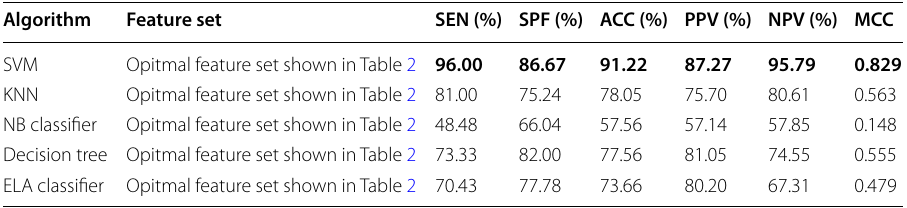
Table 5 Performance indexes for the optimal subset and for each classification algorithm using 2-fold style under normal walking speed